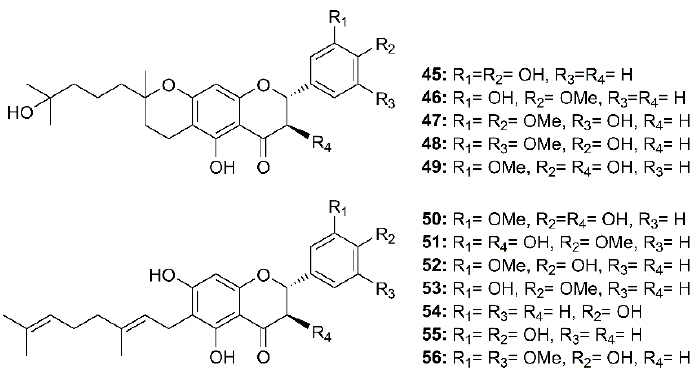
Figure 8. Structure of geranylated flavonoids 45 – 56 .